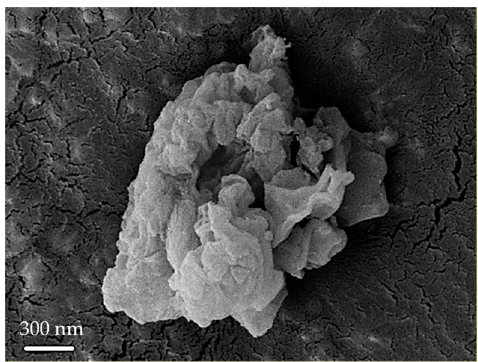
Figure 2. HRTEM image of KIT-6.